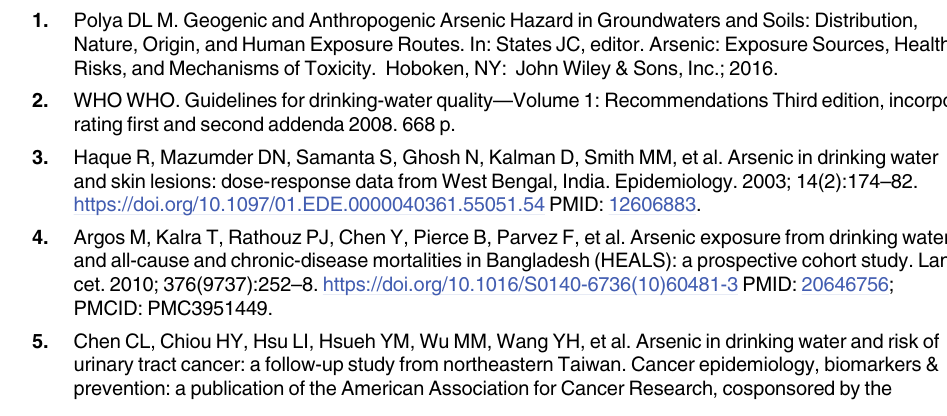
S1 Table. Differentially expressed miRNA in Arsenic-induced skin lesions and their expression reported in other types of human